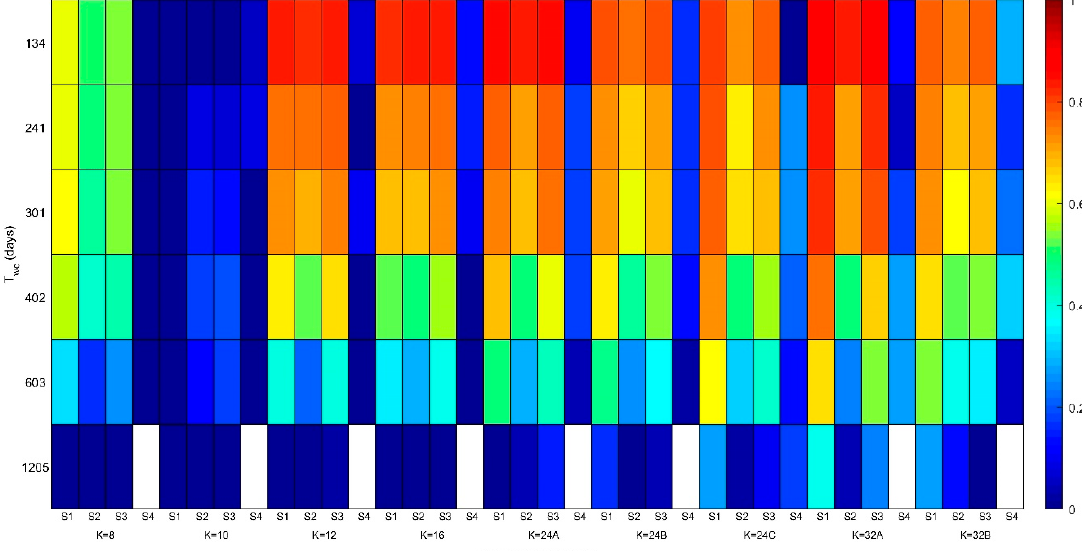
Figure 8. Average cumulative skill score of the five replicates of the different sequencing and number of cases of the Sediment Transport Bins method.